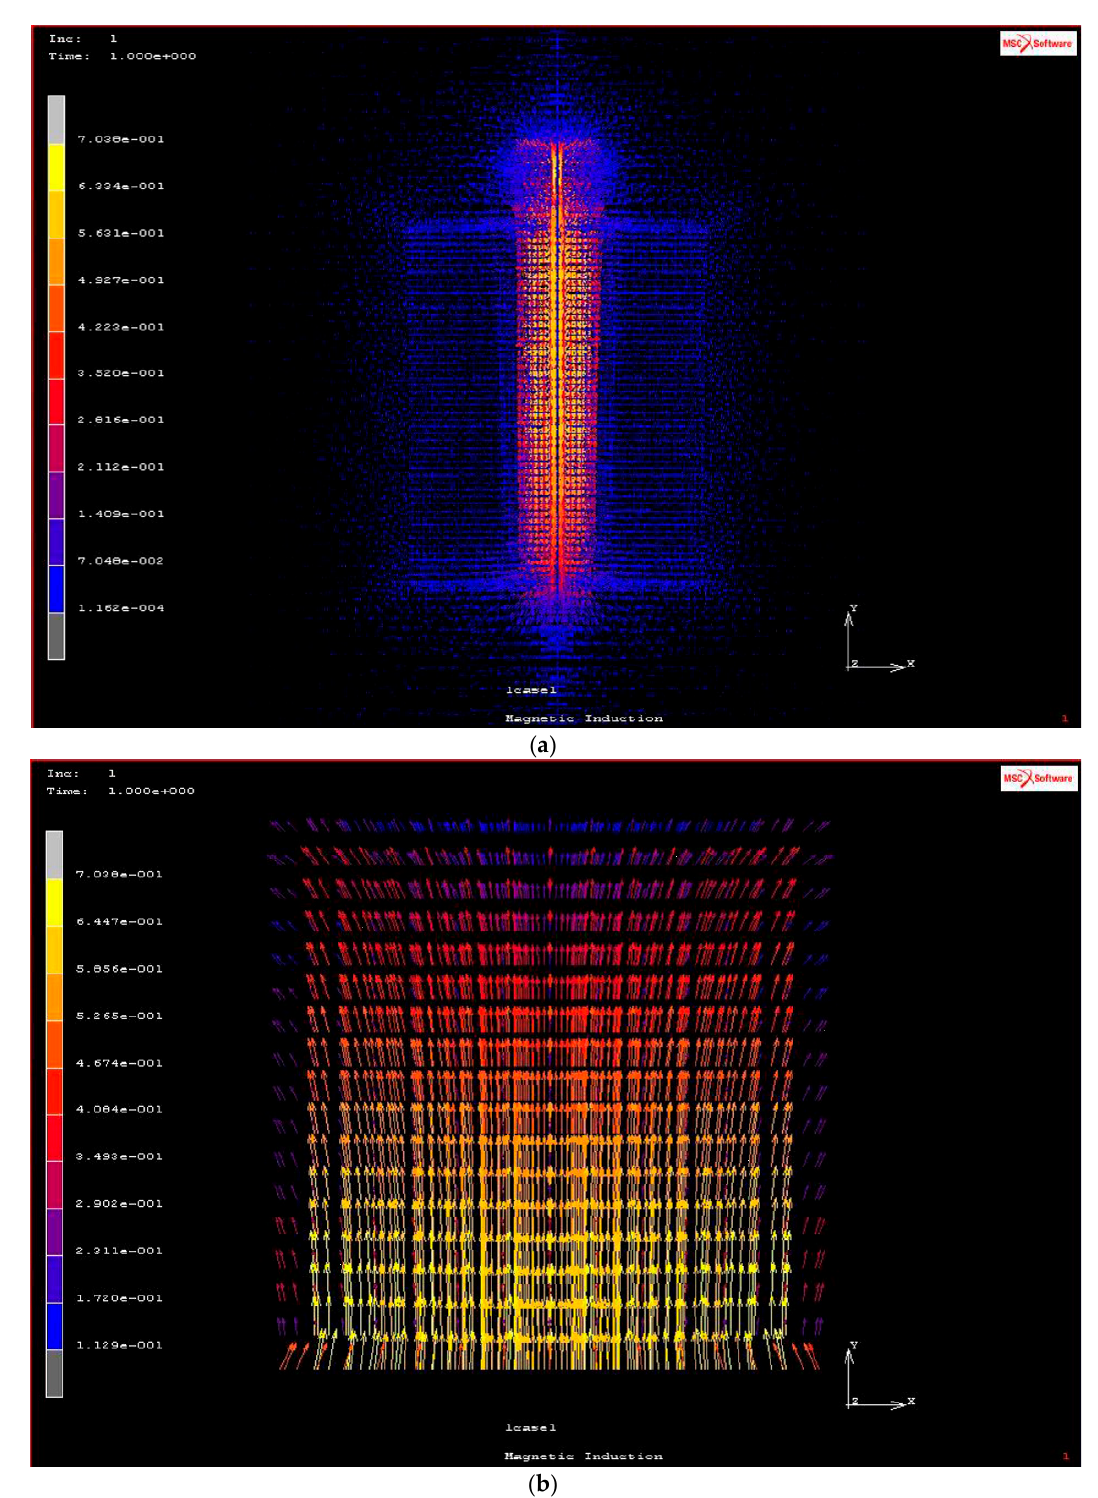
Figure 12. Magnetic induction distribution around the coil and sample on the top ( a ), and inside the 186 MRE composite ( b ). 187 MRE composite ( b